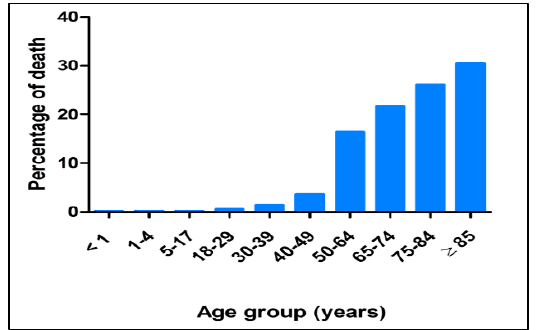
Figure 3. Percentage of death due to the coronavirus (COVID-19) in United States, May 1–August 31, 2020 increase with age (39) .